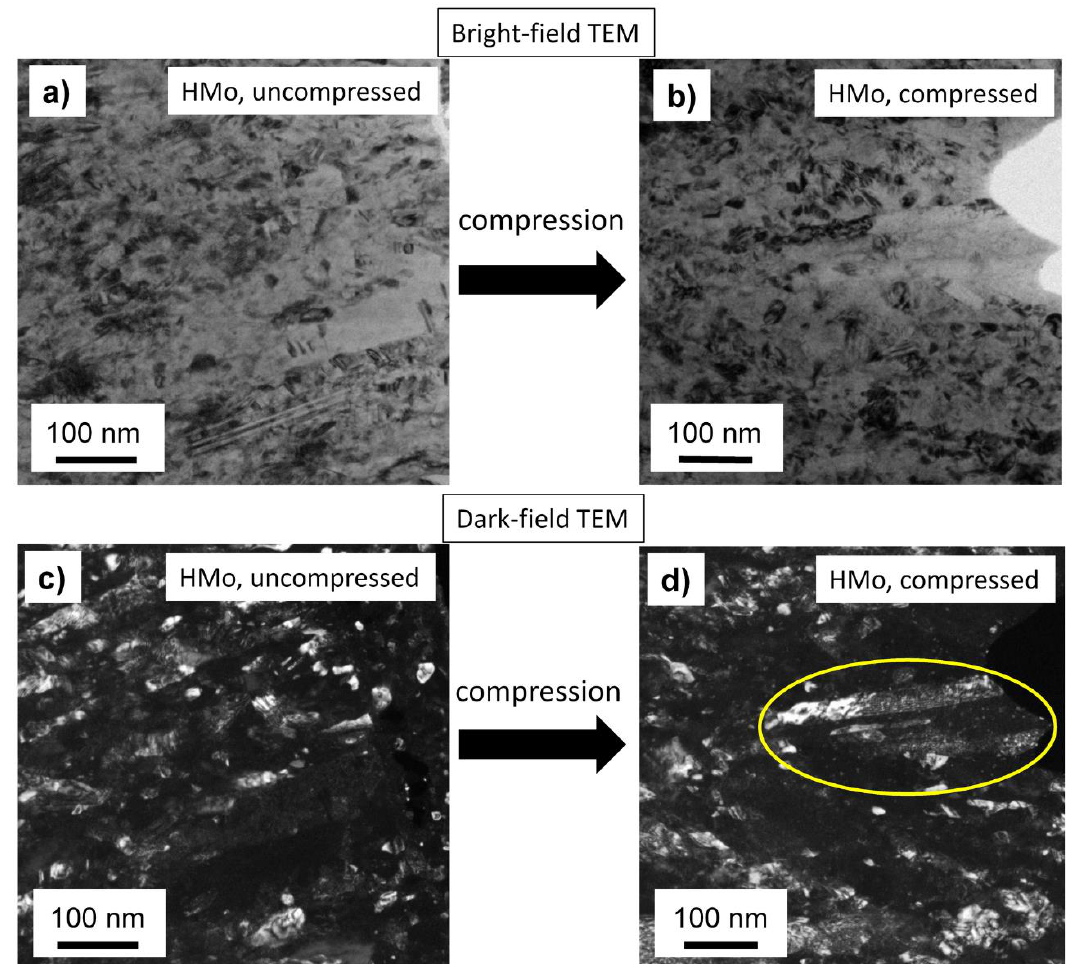
Figure 6. Bright-field ( a , b ) and the corresponding dark-field ( c , d ) TEM images taken on uncompressed ( a , c ) and compressed ( b , d ) micropillars for sample HMo.